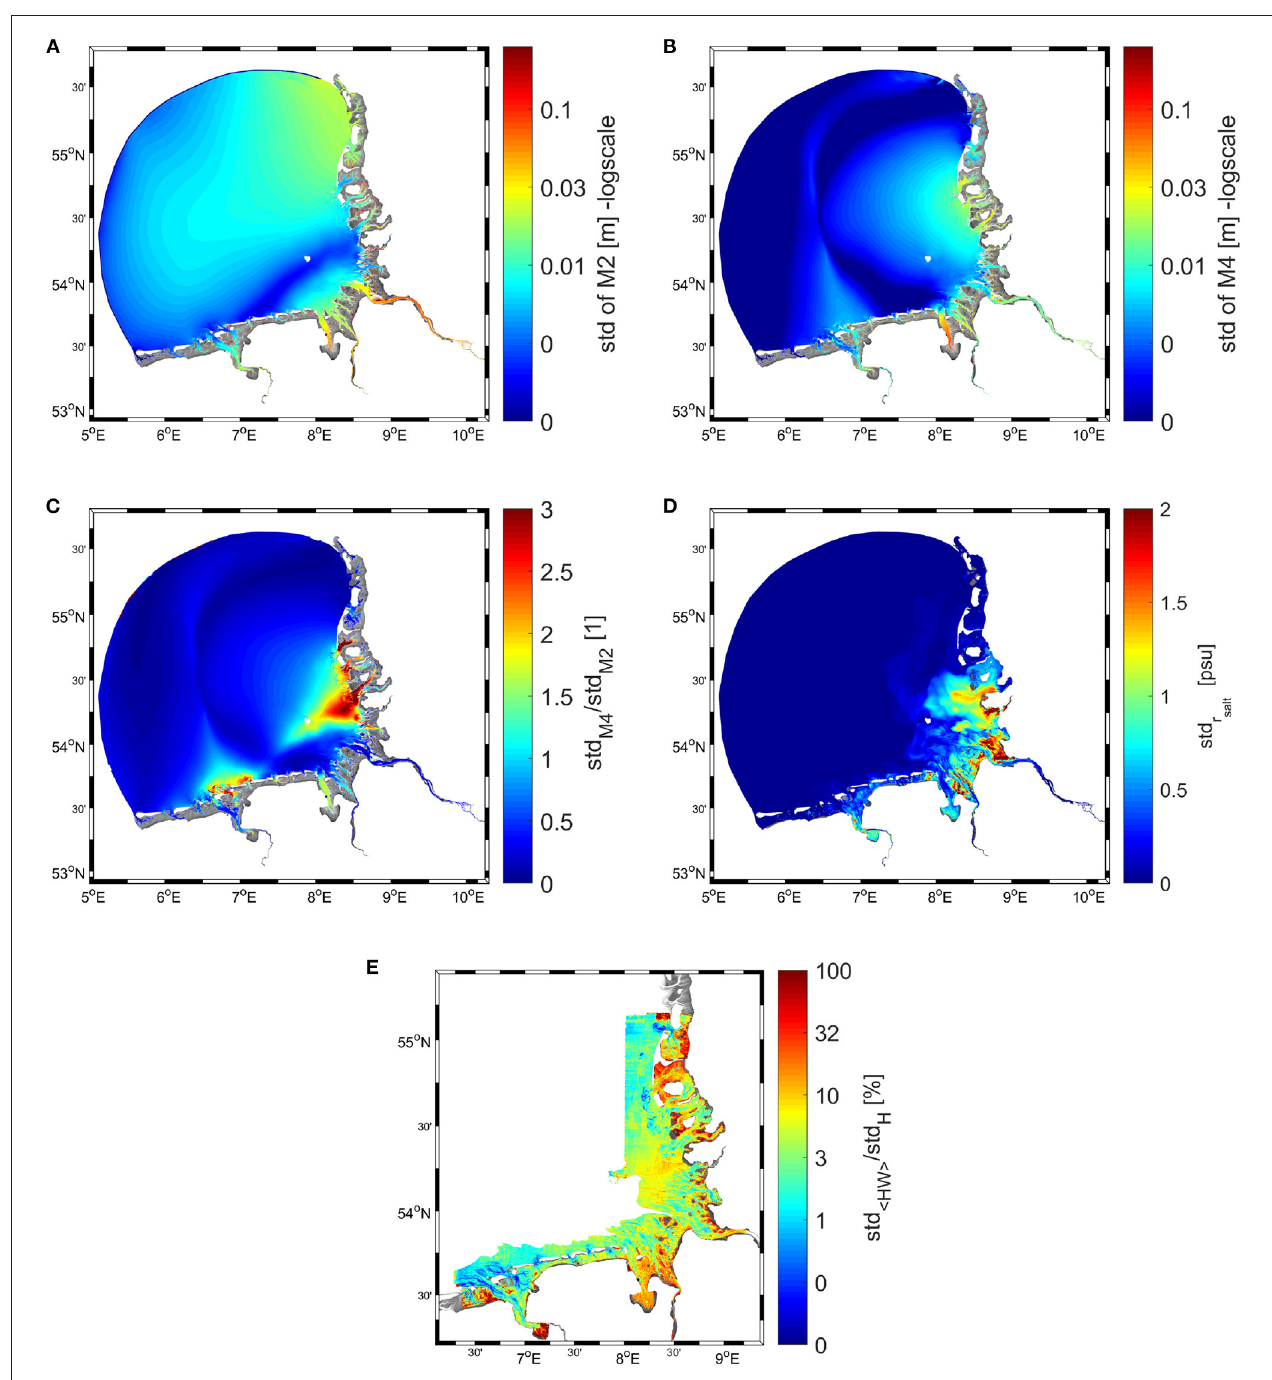
FIGURE 6 | Standard deviations of the amplitudes of the M2 (A) and M4 (B) tides in the experiments with time-referenced bathymetry. (C) Shows the ratio between (B) and (A) . The average bathymetry in an area that fell dry in any of the simulations is shown in grayscale. (D) Standard deviation of the surface salinity range. The range (r salt ) is defined as the difference between the absolute minima and maxima of the surface salinity in an individual run. (E) Standard deviation of mean high water normalized by the standard deviation of depth.